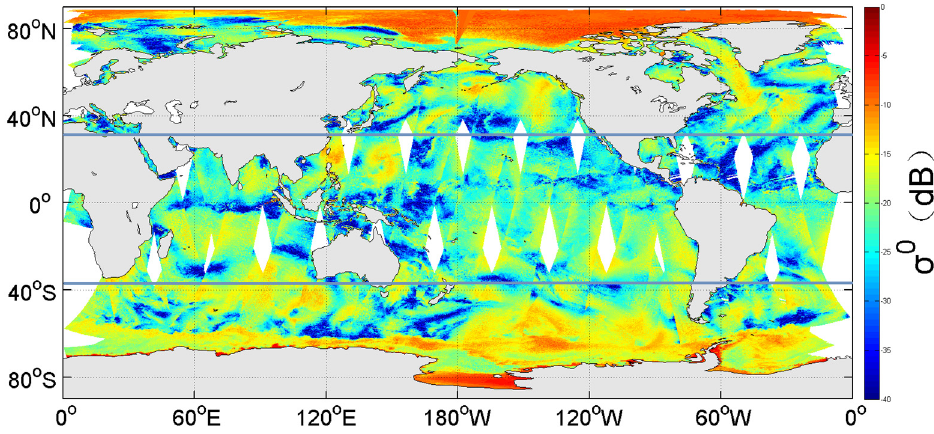
Figure 1. The daily global coverage of HY-2A/SCAT (cid:2026) (cid:2868) from the 20 September 2013.